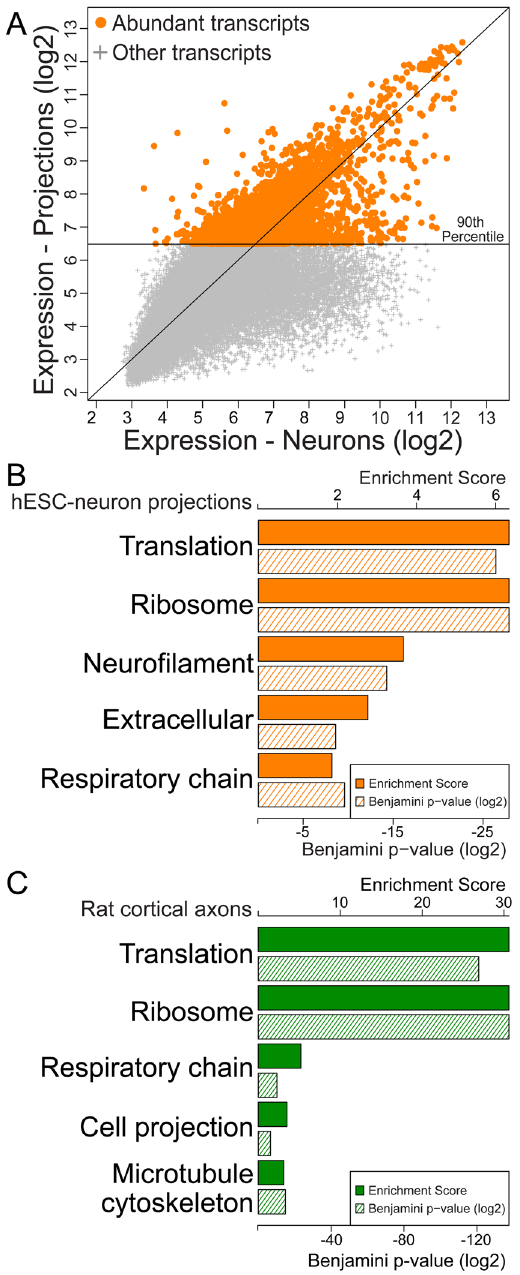
Figure 3. Enriched gene ontology categories were similar between the transcriptomes of hESC-neuron isolated distal projections and axons of embryonic rat cortical neurons. ( A ) hESC-neuron gene expression scatterplot highlighting abundant transcripts within distal projections (expression levels above the 90 th percentile). ( B ) GO enrichment scores (solid orange bars, scale along the top) and p-values (hashed orange bars, scale along the bottom) of abundant transcripts from hESC-neuron distal projections as determined by DAVID Gene Functional Classification. ( C ) GO enrichment scores (solid green bars, scale along the top) and p-values (hashed green bars, scale along the bottom) of axonal transcripts from rat cortical neurons at 13 DIV 23 as determined by DAVID Gene Functional